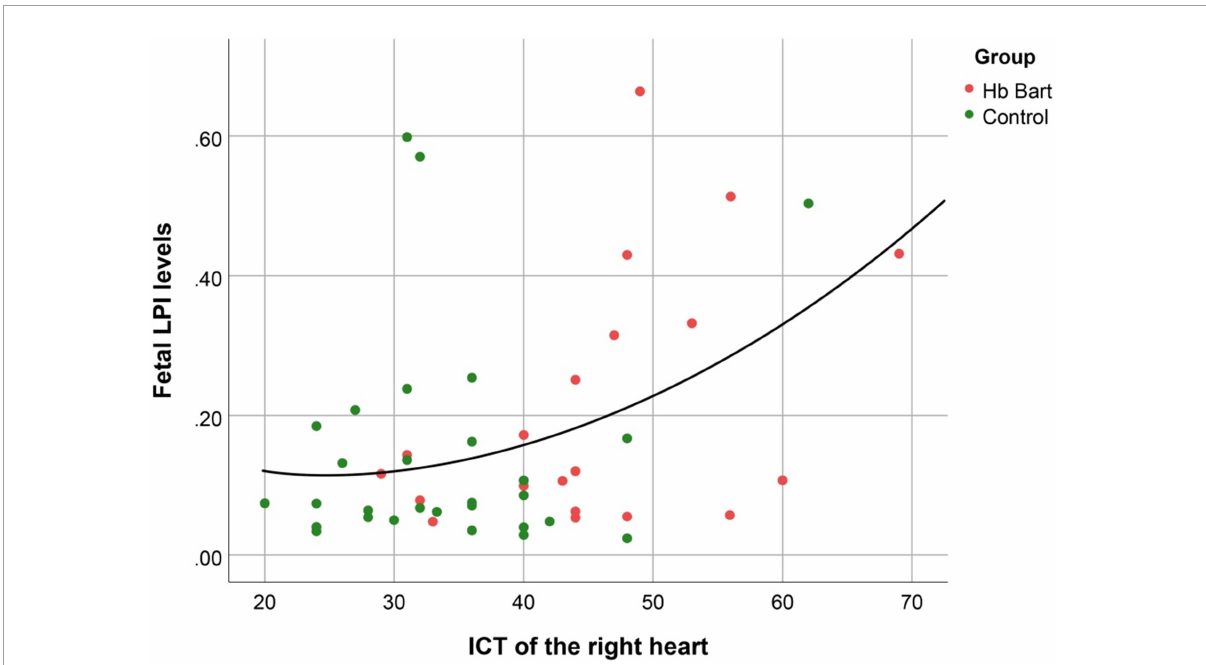
FIGURE5 The correlation between fetal LPI (Labile Plasma Iron) levels and fetal right isovolumetric contraction times (ICT) (Quadratic function; R 2 : 0.170; p : 0.013).